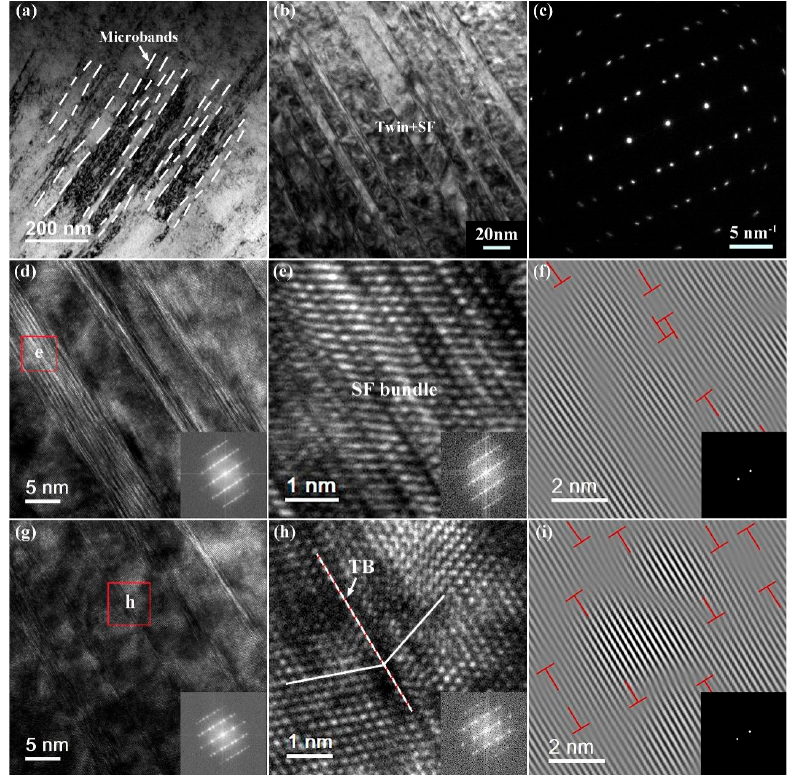
Figure 9. Microstructural features of a hydrogen-charged CoCrFeMnNi sample in a brittle zone near the fracture surface. Bright-field TEM images showing microbands with a number of dislocations ( a ) and twinning ( b ); ( c ) Selected area electron diffraction; ( d , g ) High resolution TEM images showing twinning and stacking fault bundles with various sizes; ( e , h ) Enlarged images of the regions ( e , g ) in ( d , g ), showing stacking fault (SF) bundles and twinning boundary (TB); ( f , i ) showing edge dislocations marked by red color. To compare the effect of hydrogen on the microstructural features, statistical analysis of the microband gap, number of twins, and width of SF bundles in hydrogen-charged and uncharged CoCrFeMnNi samples was conducted (Figure 10). The average microband gap is determined to be 26.62 nm for the uncharged sample, whereas it is 46.96 nm for hydrogenated sample. Conversely, the number of twins and the width of SF bundles increases after hydrogen charging, with the average number of twins and average width of SF bundles calculated to be 2.57 and 5.02 nm for the uncharged sample and 2.71 and 5.77 nm for the hydrogen-charged sample. These results demonstrate that the presence of hydrogen promotes the formation of SFs and twinning.